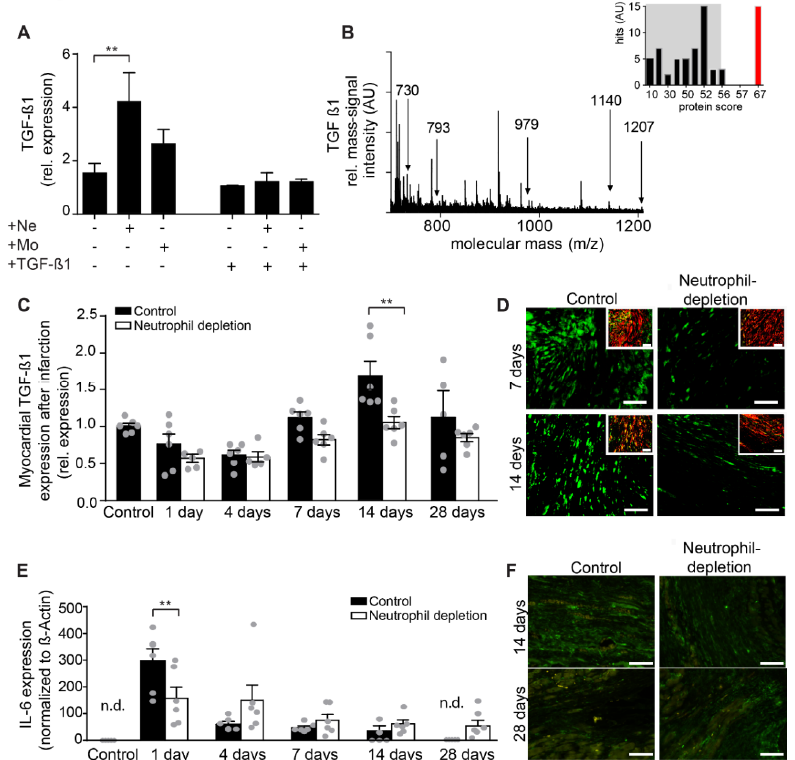
Figure 4. The effect of neutrophils on TGF-β1 dynamics during MI. ( A ) TGF-β1 mRNA expression in fibroblasts (–TGF-β1) and myofibroblasts (+TGF-β1) co-incubated under hypoxic conditions without/with neutrophil and mononuclear fractions, respectively ( n = 4–8, ** p < 0.01). ( B ) Characteristic MALDI mass fingerprint-spectrum of tryptic peptides of TGF-β1 in fibroblast lysates after co-incubation with neutrophil fraction. Protein score from MASCOT database is shown in the right inset. ( C ) Time-dependent myocardial mRNA expression of TGF-β1 after MI ( n = 5−6, ** p < 0.01). ( D ) TGF-β1 staining in myocardium by immunofluorescence (green) at different MI set points in control and in neutrophil-depleted mice ( n = 5−6). Double immunofluorescence of TGF-β1 (green), smooth alpha actin (red) and overlay (yellow) at different MI set points is shown in insets (scale bar 50 µm). ( E ) Time-dependent myocardial mRNA expression of IL-6 after MI ( n = 6, ** p < 0.01, n .d. not detected) in mice without (black columns) and with (white columns) neutrophil depletion. ( F ) Representative double immunofluorescence of IL-6 (green) at different MI set points is shown in insets (scale bar 50 µm).